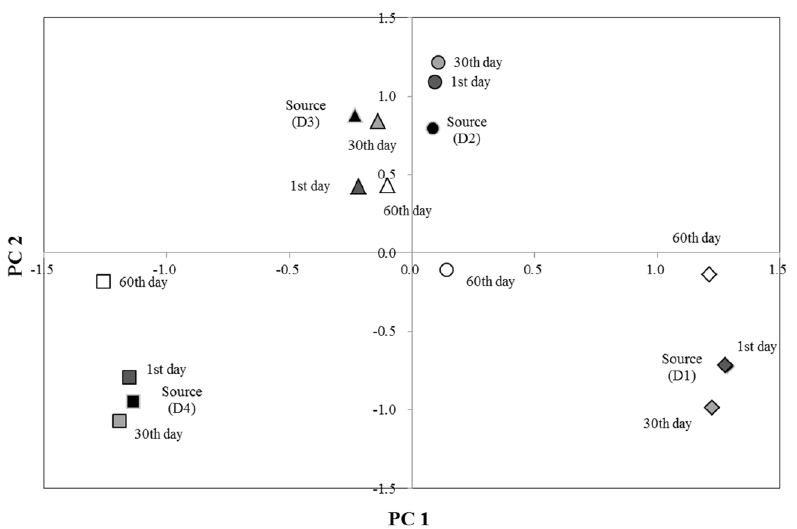
Figure 2. PCA for the relative FAME compositions and proportion in the diesel sources and soil samples contaminated with the corresponding sources at different weathering time; ♦ D1,